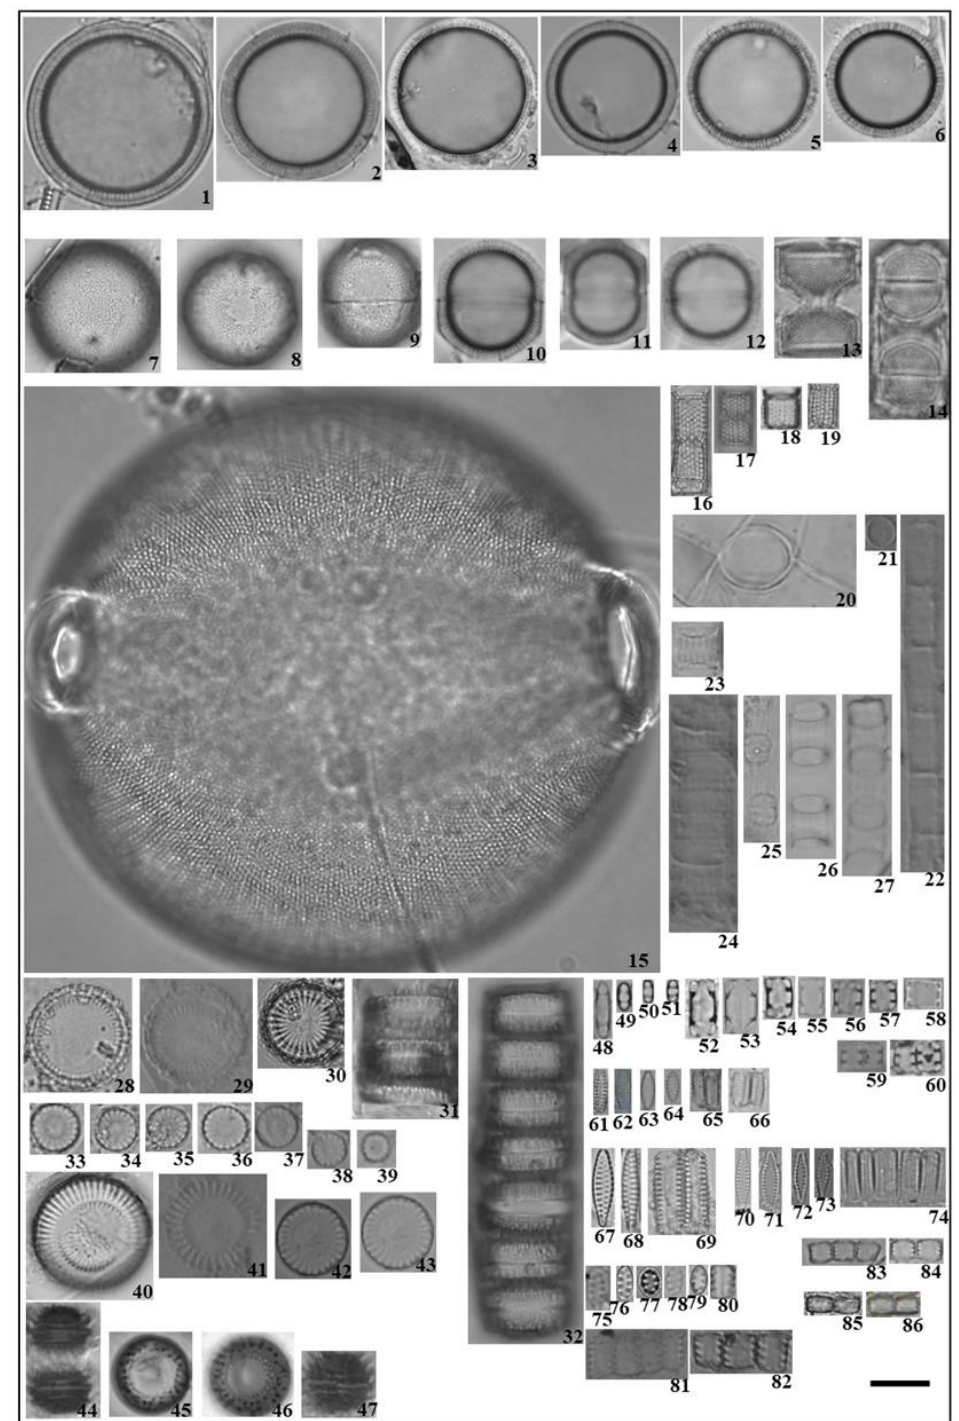
Figure 3. Melosira moniliformis var. octogona (1 – 14); Pleurosira leavis (15); Aulacoseira granulata (16 – 19); Chaetoceros sp. (20); S. potamos (21 – 22); Skeletonema sp.2 (23 – 24); Skeletonema sp.3 (25 – 27); Paralia sulcata (28 – 32); Cyclotella sp.1 (33 – 39); Cyclotella striata (40); Cyclotella meneghiniana (41 – 43); Pseudopodosira echinus (44 – 47); Ambo tenuissimum (48 – 60); Pseudostaurosira brevistriata (61 – 66); P. clavatum (67 – 69); Pseudostaurosiropsis geocollegarum (70 – 74); Staurosirella aff. ovata (75 – 82); S. guenter-grassi (83 – 84); Fragilaria sp.1 (85 – 86). Scale bar = 10 μ m.